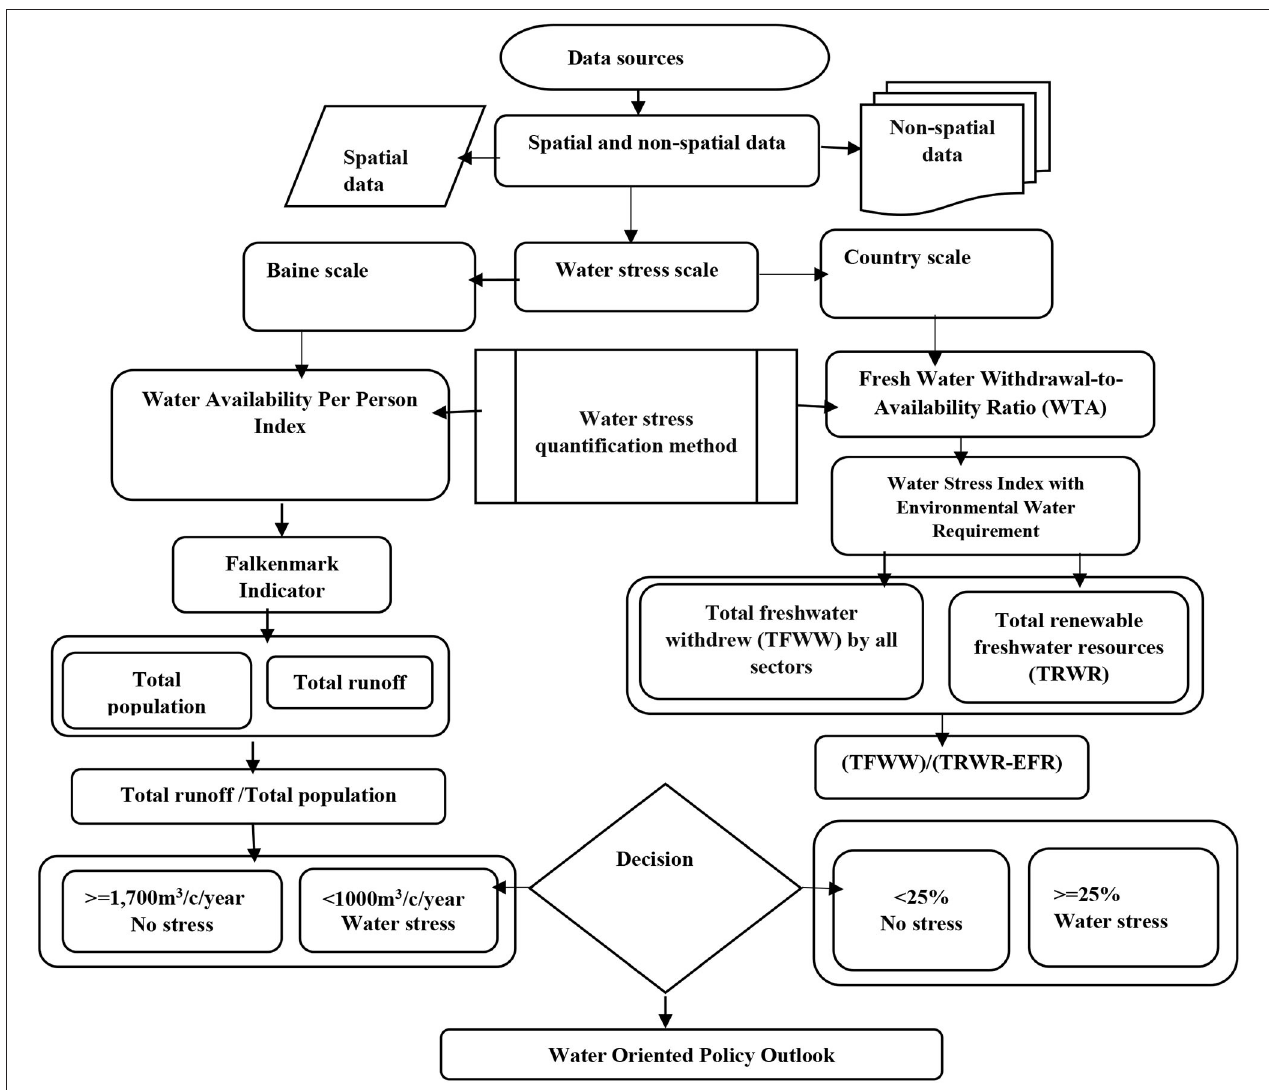
FIGURE 3 | A flow chart of methodological approach to estimate a water stress level at basin and country